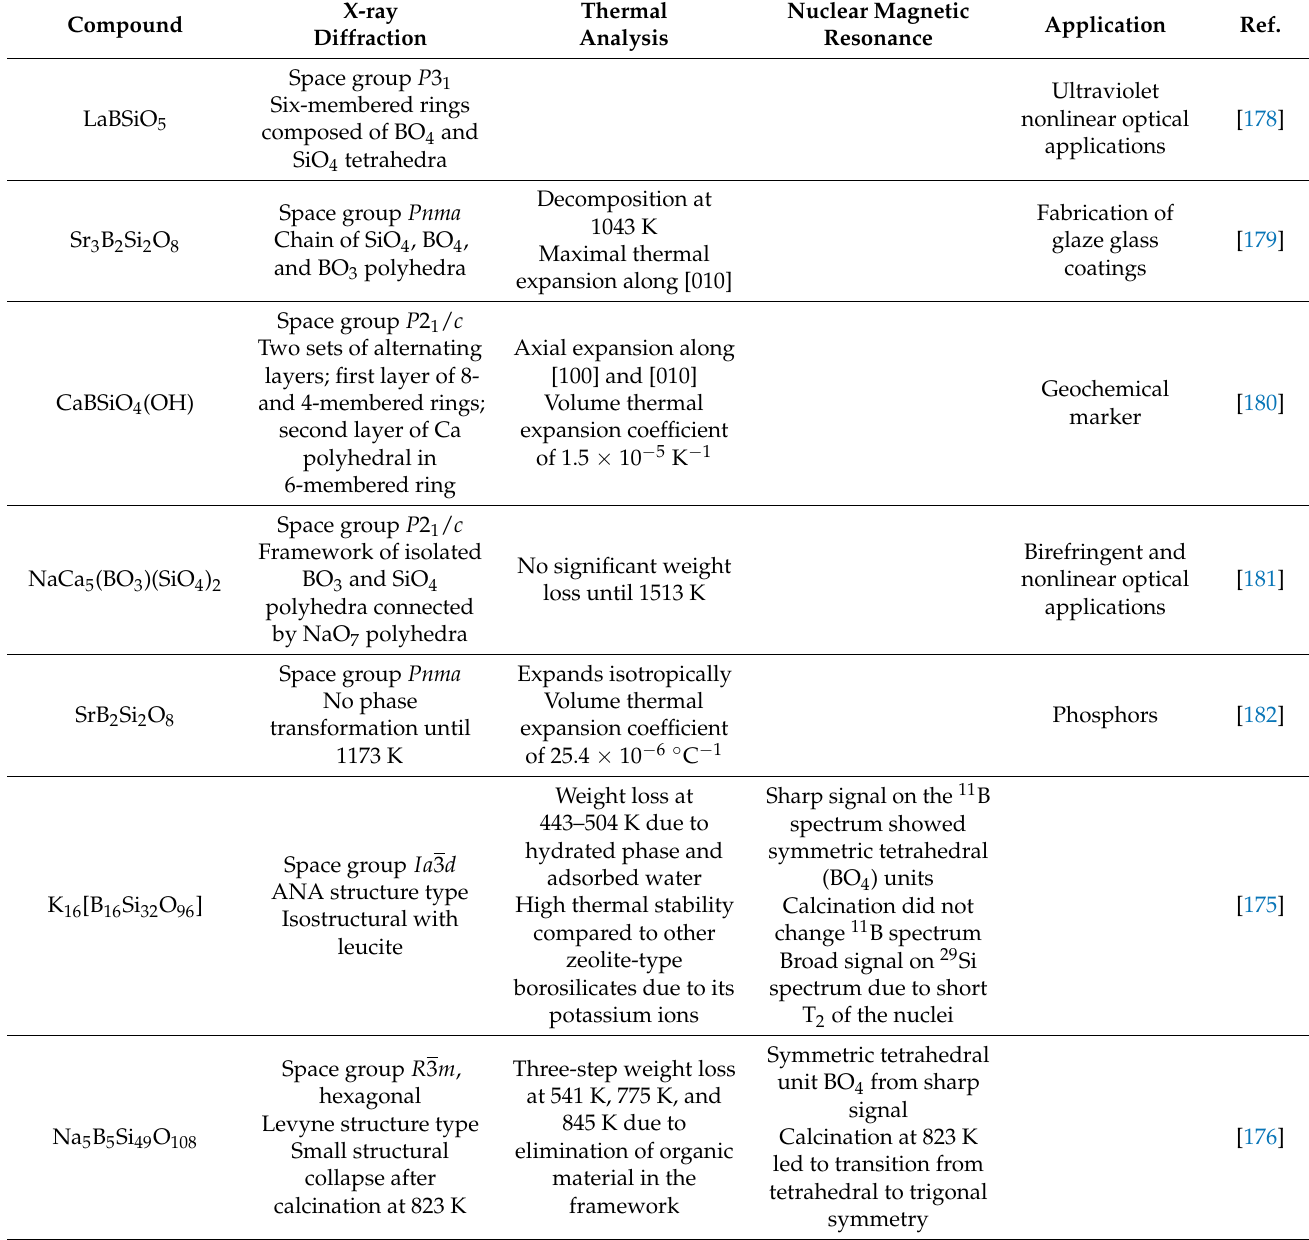
Table 8. Properties of different BSiO structure